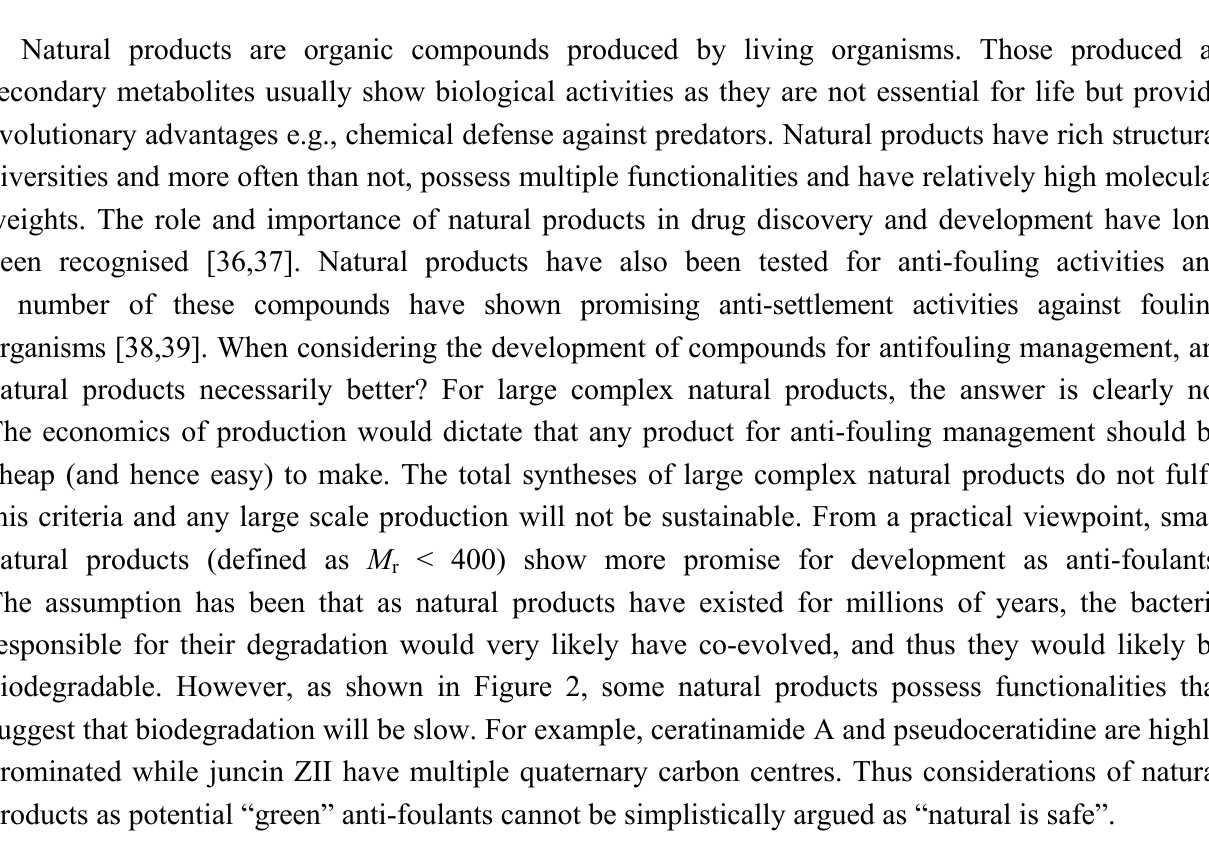
Figure 2. Examples of complex natural products containing anti-foulant